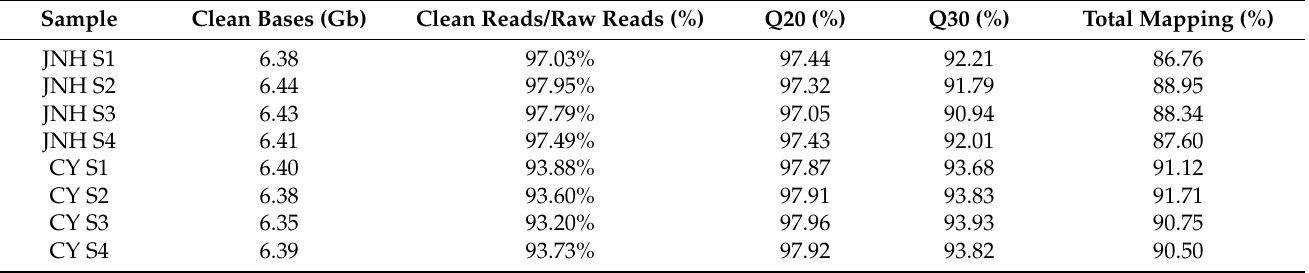
Table 4. The quality assessment of sequencing data of cultivars with different packaging materials.